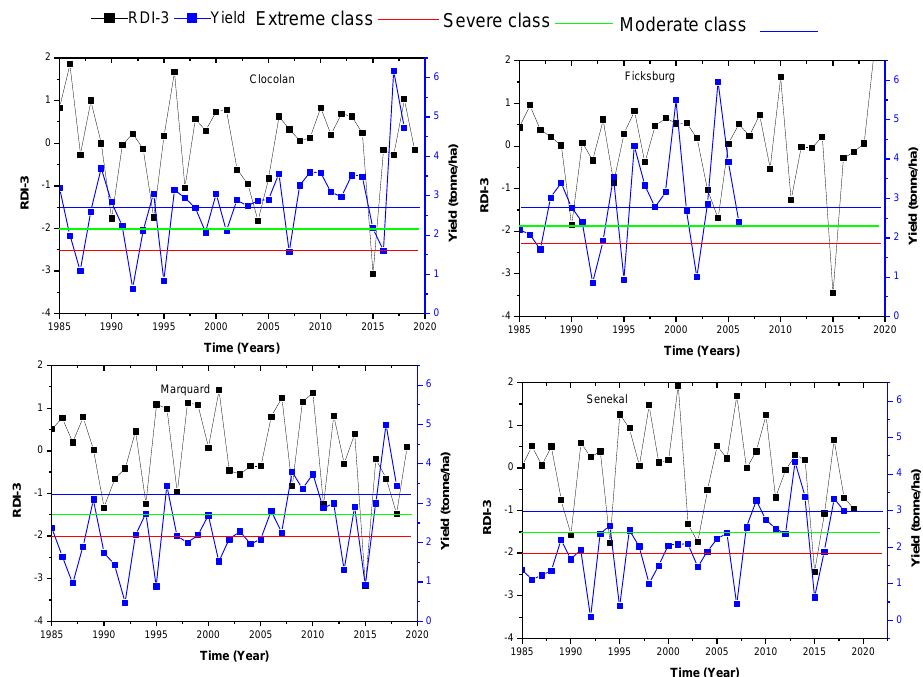
Figure 2. RDI-3 (black trendline) Setsoto municipality drought index (OND) and maize yield (blue trendline) for the period between 1985 and 2019.